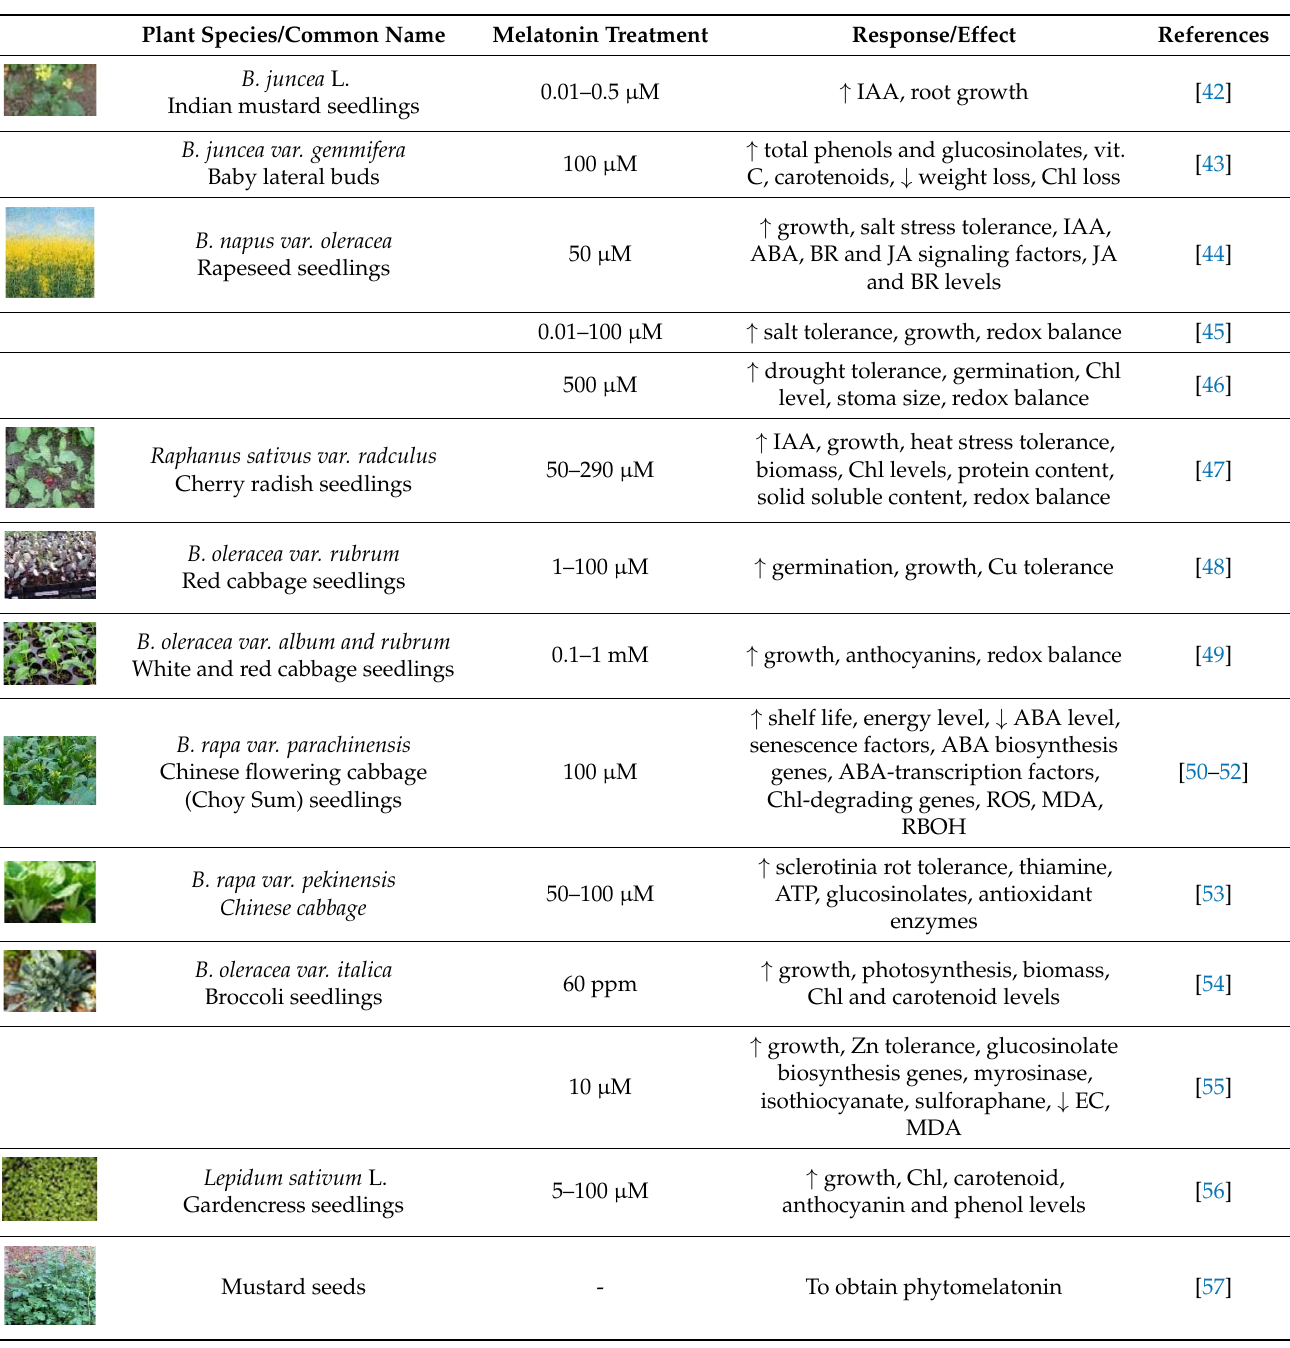
Table 1. Brassicaceae plants used in melatonin studies.